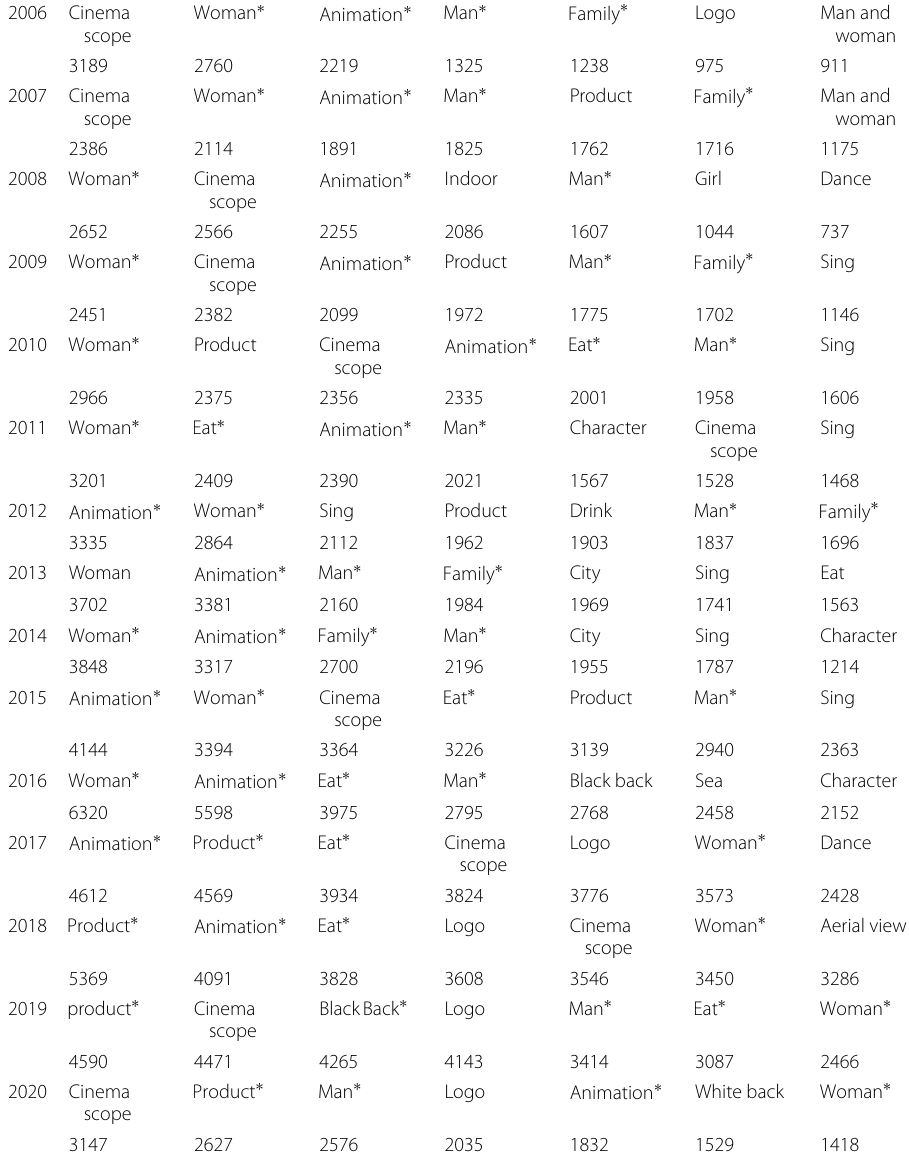
Table 4 Community